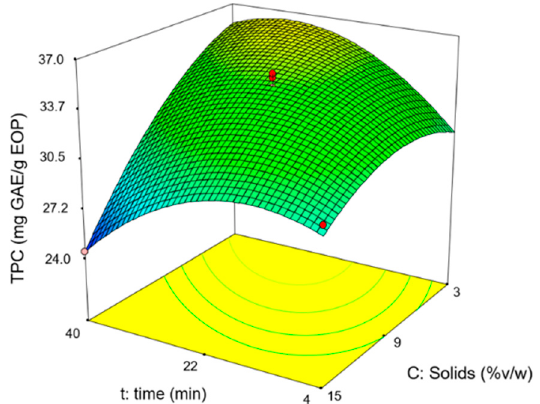
Figure 1. Response surface for the total phenol content (TPC) at 70 °C.